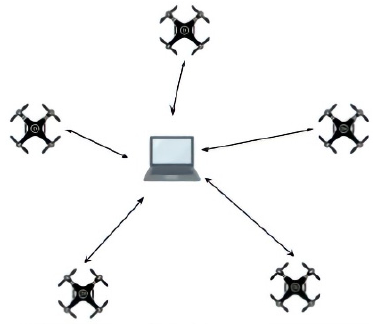
Figure 4. Topology of the